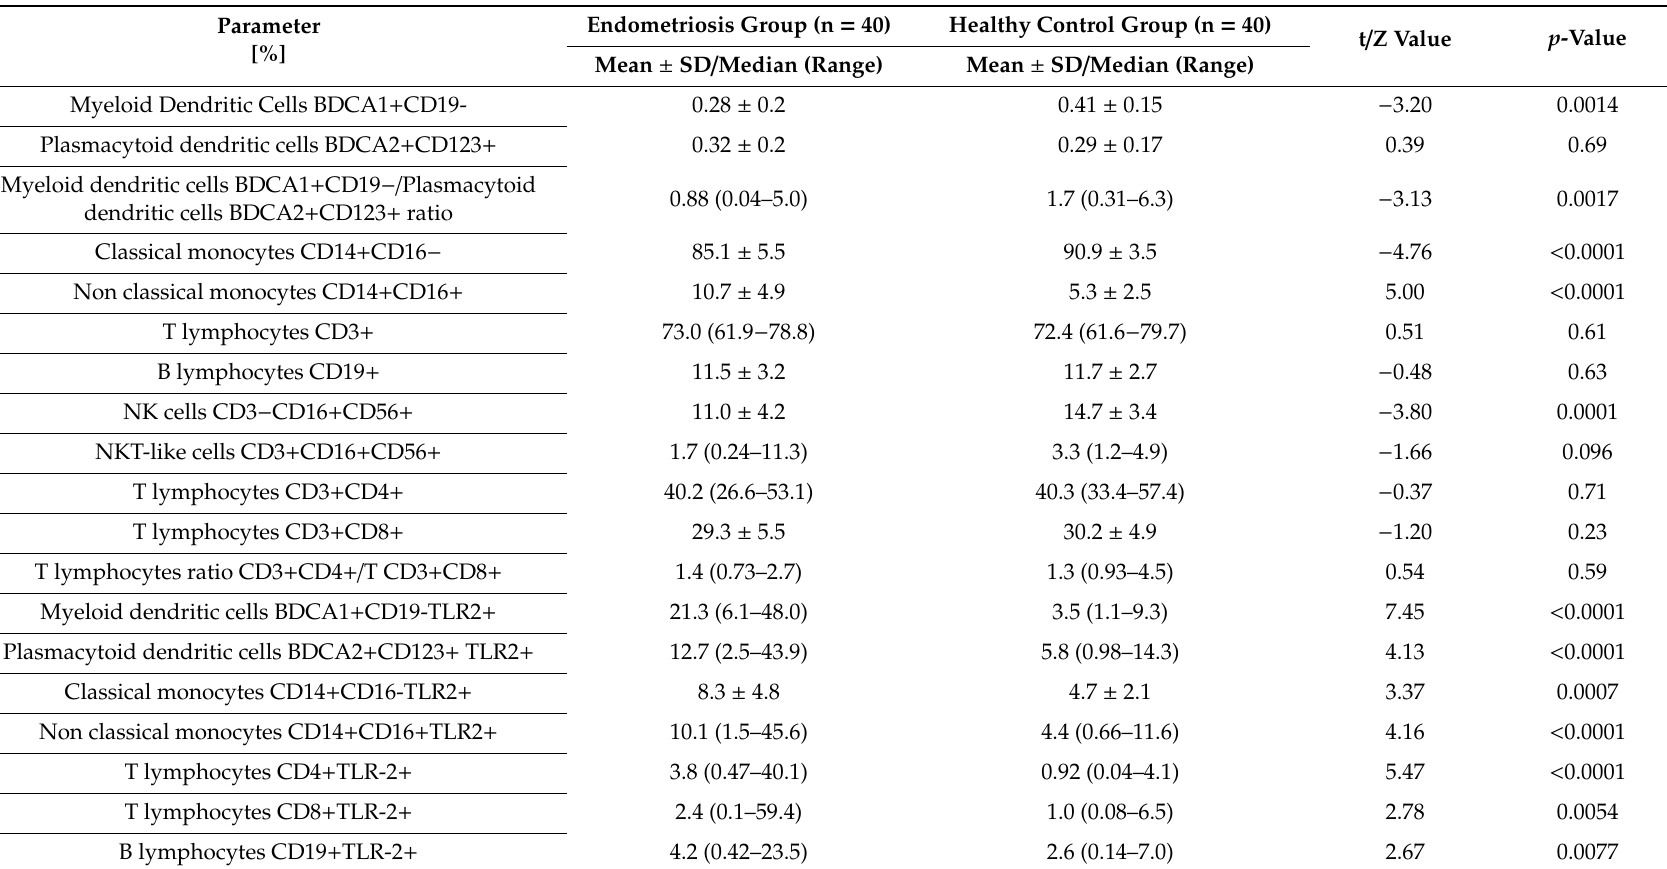
Table 2. The frequencies of the dendritic cells, monocytes, and basic peripheral blood lymphocyte subsets as well as the frequencies of these cell subsets expressing TLR2 antigen, for the patients and